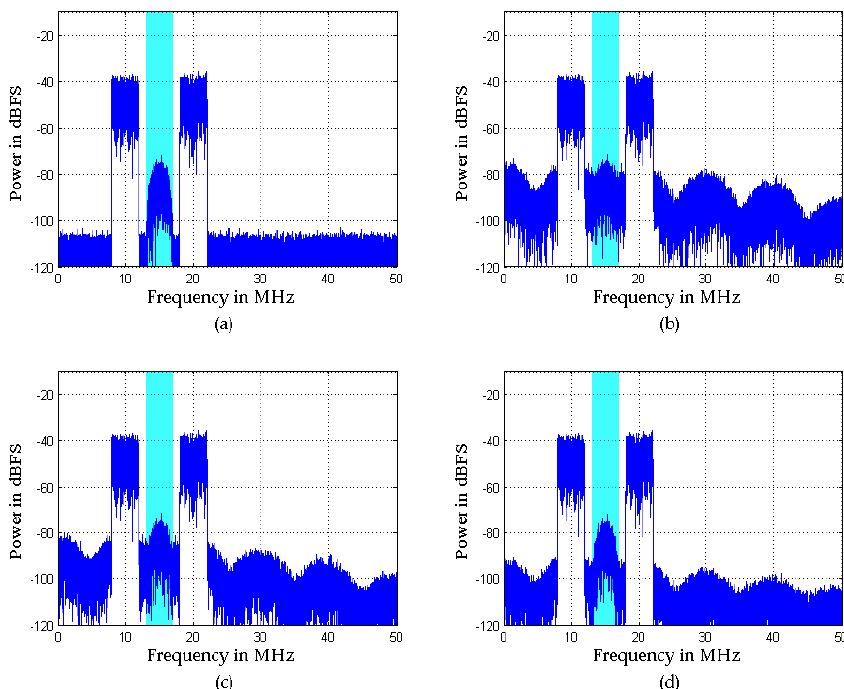
Figure 10. Simulation results with the two-tone interferer signal: ( a ) original signal; ( b ) distorted algorithm; ( c ) output of AIC; ( d ) output of the proposed algorithm.